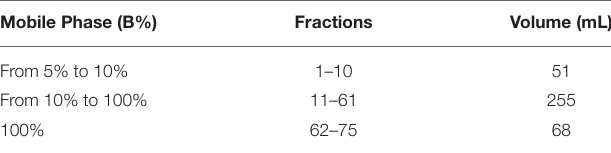
TABLE 2 | Mobile phase used for the further OC